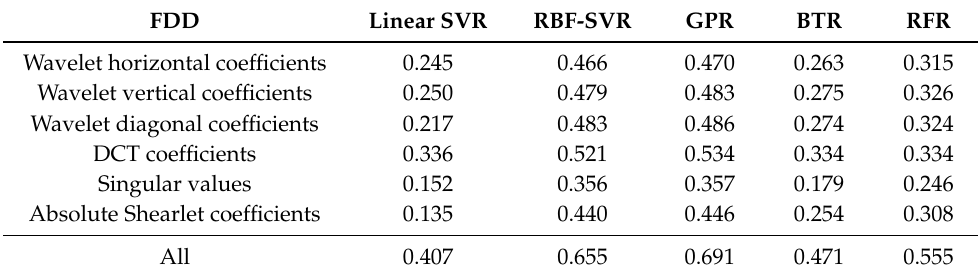
Table 5. Comparison of different FDD feature vectors extracted from different domains and different regression modules on KonIQ-10k [21] database. Median SROCC values were measured over 1000 random train–test